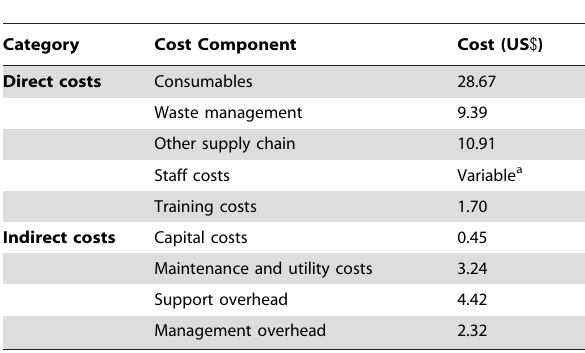
Table 2. VMMC unit cost